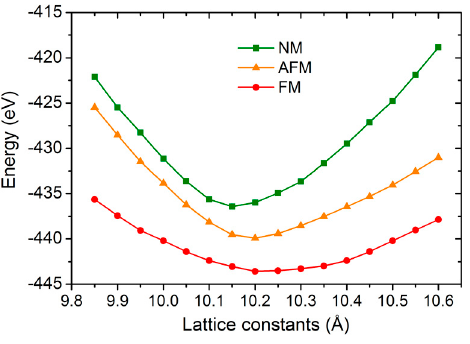
Figure 2. Figure 2. The total energies of GaFe(CN) 6 in ferromagnetic (FM), non-magnetic (NM), and antiferromagnetic (AFM) states.